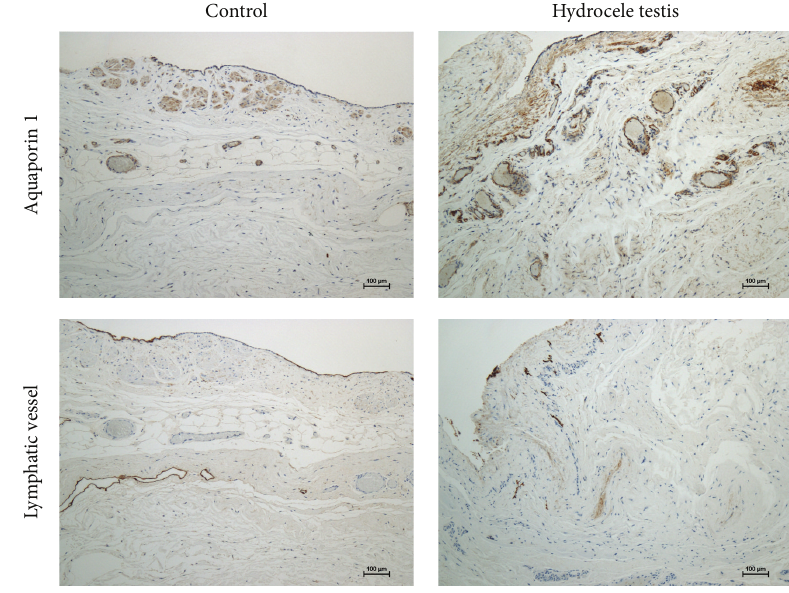
Figure 3: Histochemistry of aquaporin 1 and lymphatic vessels. Table 1: Biochemical analysis of the serum and hydrocele fluid.